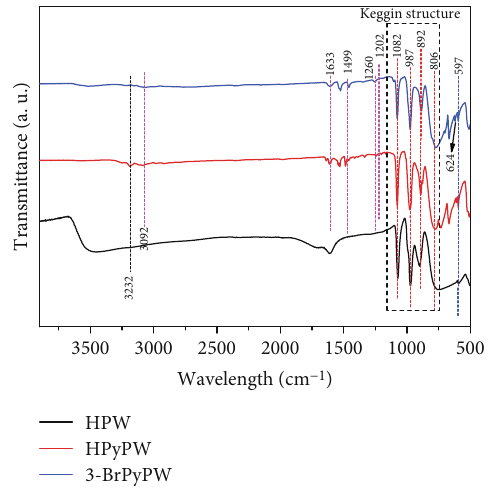
Figure 1: XRD patterns of 3-BrPyPW, HPyPW, and HPW. Figure 2: FT-IR spectra of 3-BrPyPW, HPyPW, and